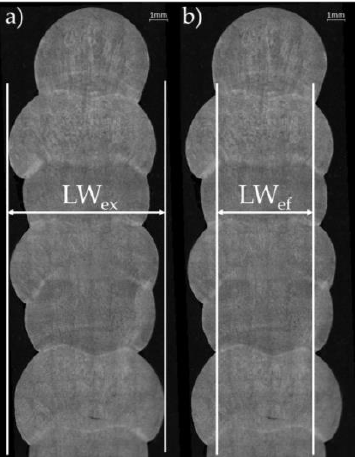
Figure 16. Representation of: ( a ) maximum external LW (LW ex ); ( b ) minimum effective LW (LW ef ). Table 8. Experimental responses: external layer width (LW ex ) and effective layer width (LW ef ). Exp.